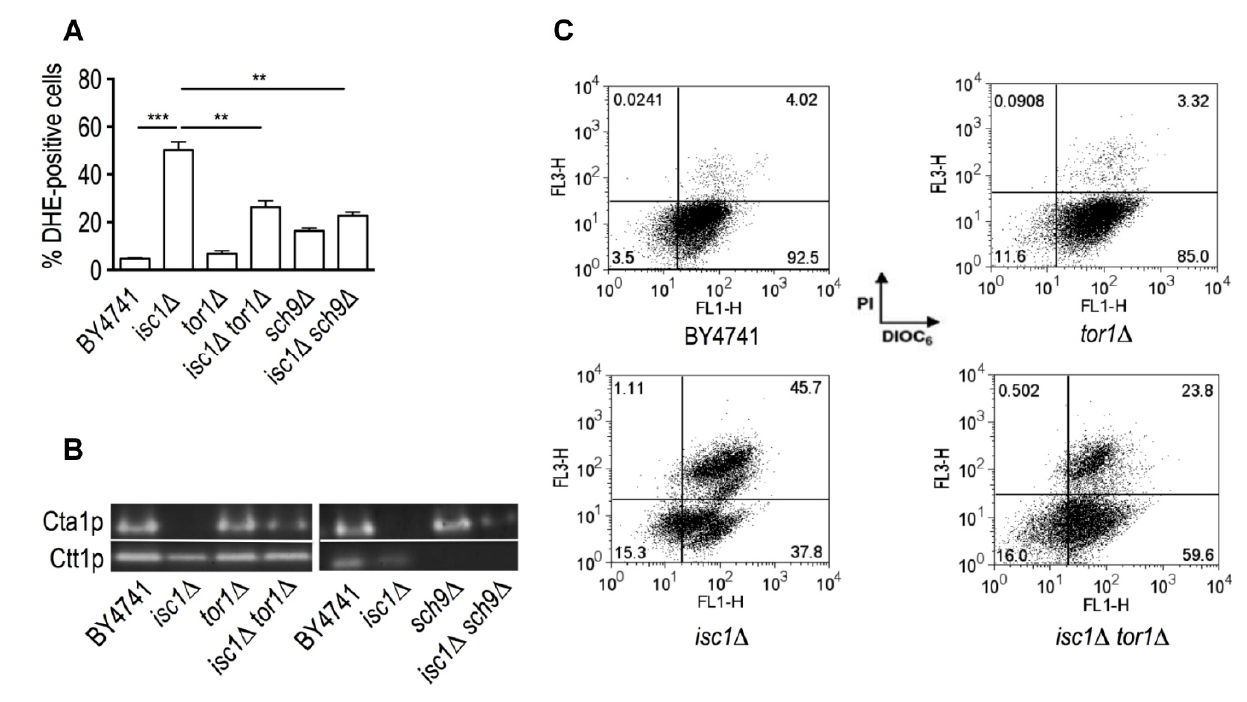
FIGURE 5: The deletion of TOR1 or SCH9 decreases ROS production, attenuates catalase A deficiency and diminishes apoptotic cell death in isc1 Δ cells. (A) S. cerevisiae BY4741, isc1 Δ , tor1 Δ and isc1 Δ tor1 Δ, sch9 Δ and isc1 Δ sch9 Δ cells were grown to early stationary phase (day 1 in the CLS assay), stained with the dihydroethidium (DHE) for 10 min and analyzed by flow cytometry. Values are mean ± SD of at least three in- dependent experiments. ***p<0.001; **p<0.01. (B) Yeast cells were grown to the PDS phase and catalase activity was detected in situ after non-denaturing polyacrylamide gel electrophoresis, using the H 2 O 2 /peroxidase system, as described in Materials and Methods . A representa- tive experiment out of three is shown. (C) BY4741, isc1 Δ , tor1 Δ and isc1 Δ tor1 Δ cells were double stained with DiOC 6 (3) and PI (propidium io- dide) and analyzed by flow cytometry, as described in Materials and Methods . Representative histograms are